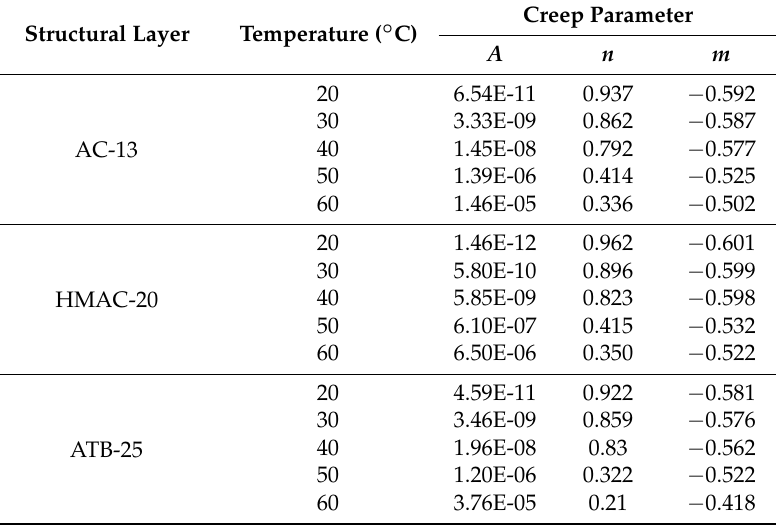
Table 11. Creep parameters of asphalt mixture at different